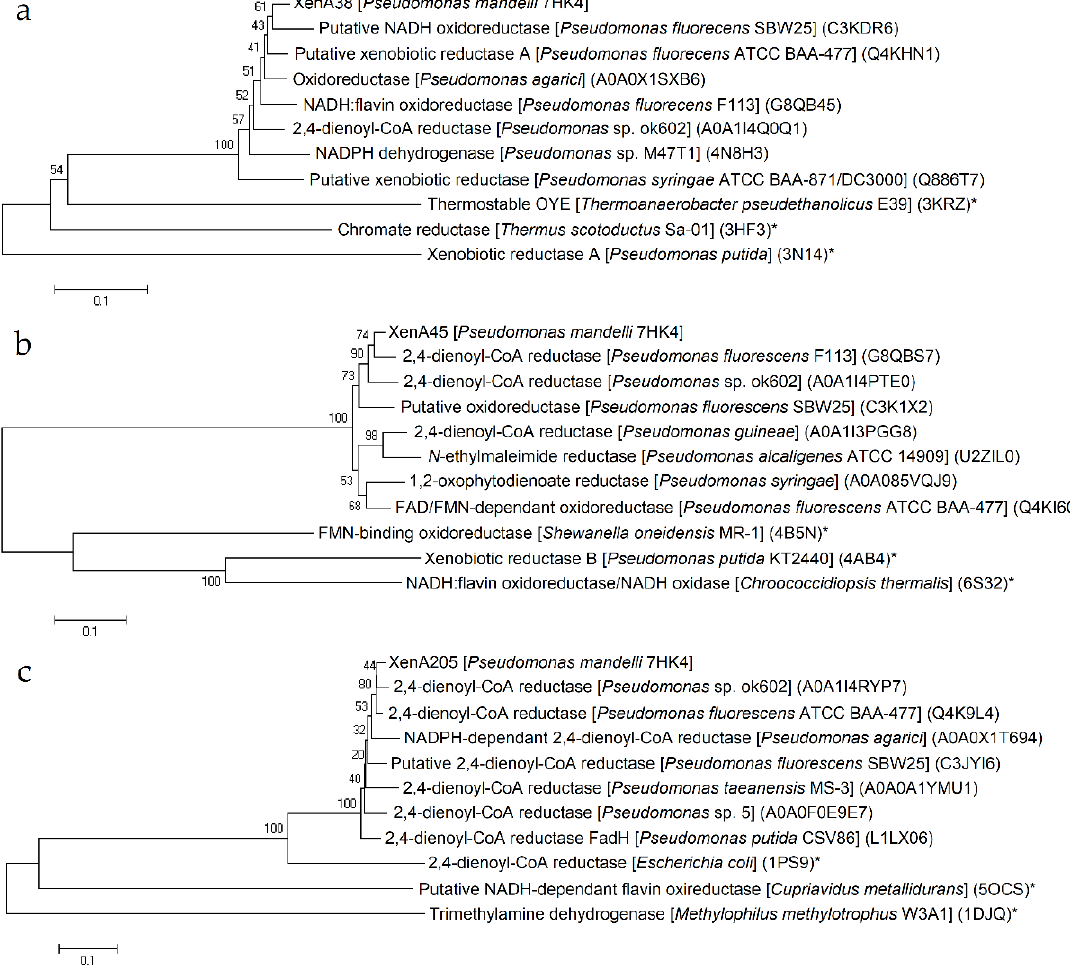
Figure 1. Phylogenetic analysis of XenA38 ( a ), XenA45 ( b ) and XenA205 ( c ) proteins from Pseudomonas mandelii 7HK4 bacteria. Neighbor joining analyses were performed on the closest homologues with or without known structures and/or function. The numbers on the nodes indicate how often (no. of times, %) the species to the right grouped together in 1000 bootstrap samples. Bars represent the number of amino acid substitutions per site. UniProt/PDB accession numbers are given in parentheses. Proteins with known structure and/or function are marked with an asterix (*).